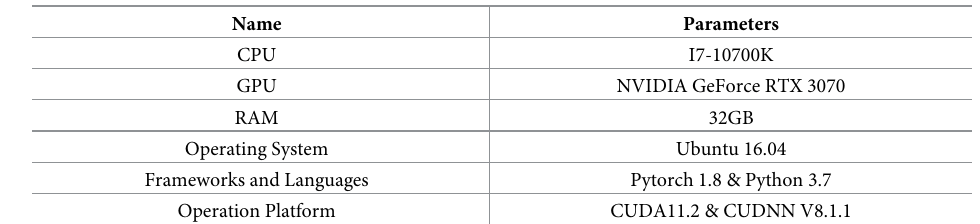
Table 3. Software and